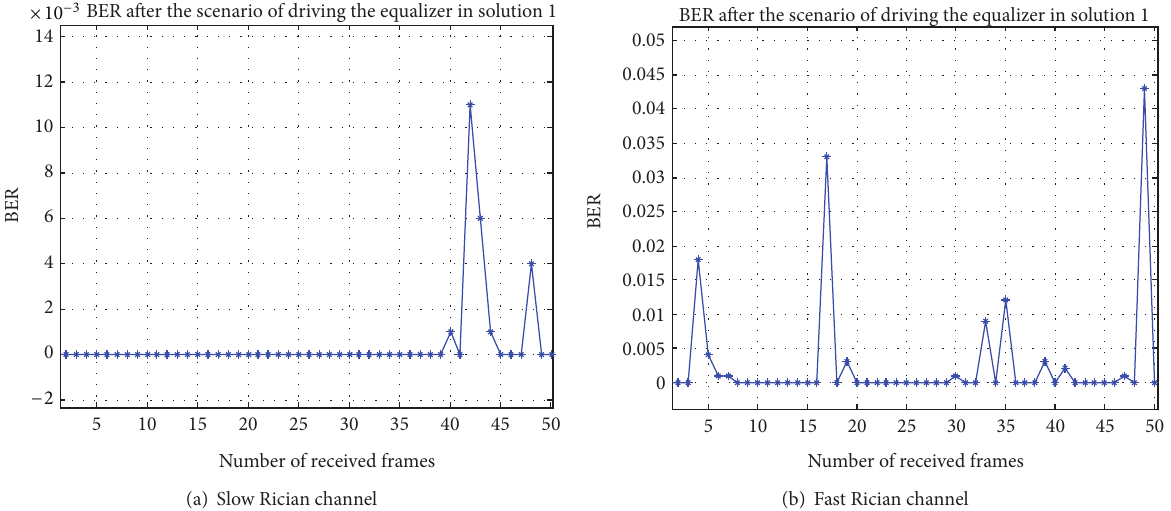
F 8: Performance of the system aer decision making for the Rician channel with solution 1: errors of the equalizer due to its interruptions and reinitializations.